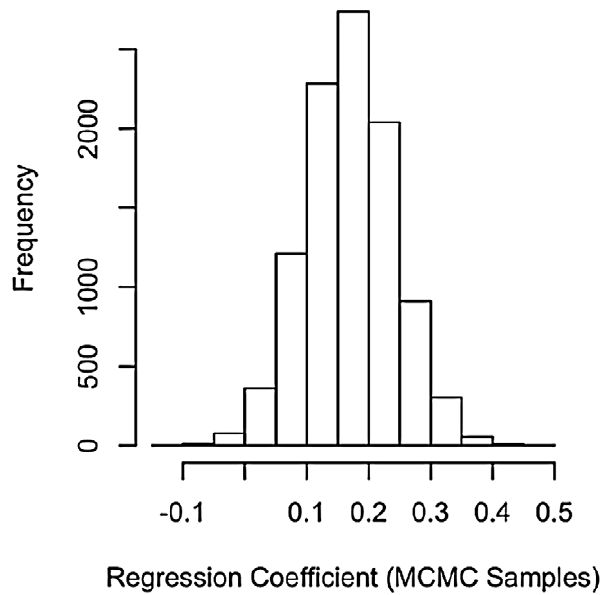
Figure 5. Regression coefficients relating estrous overlap to the number of males. The distribution of regression coefficients was obtained from the MCMC analysis. Note that most coefficients sampled are larger than zero, providing strong support for an association between these two variables.